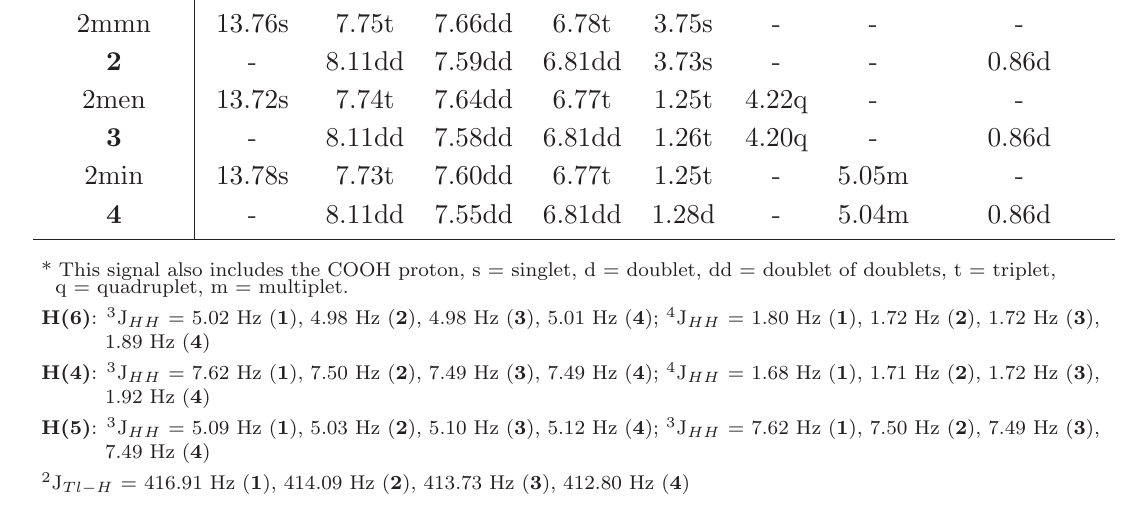
Table 10 1 H NMR data ( δ , ppm) for the free ligands and [TlMe 2 (L)]